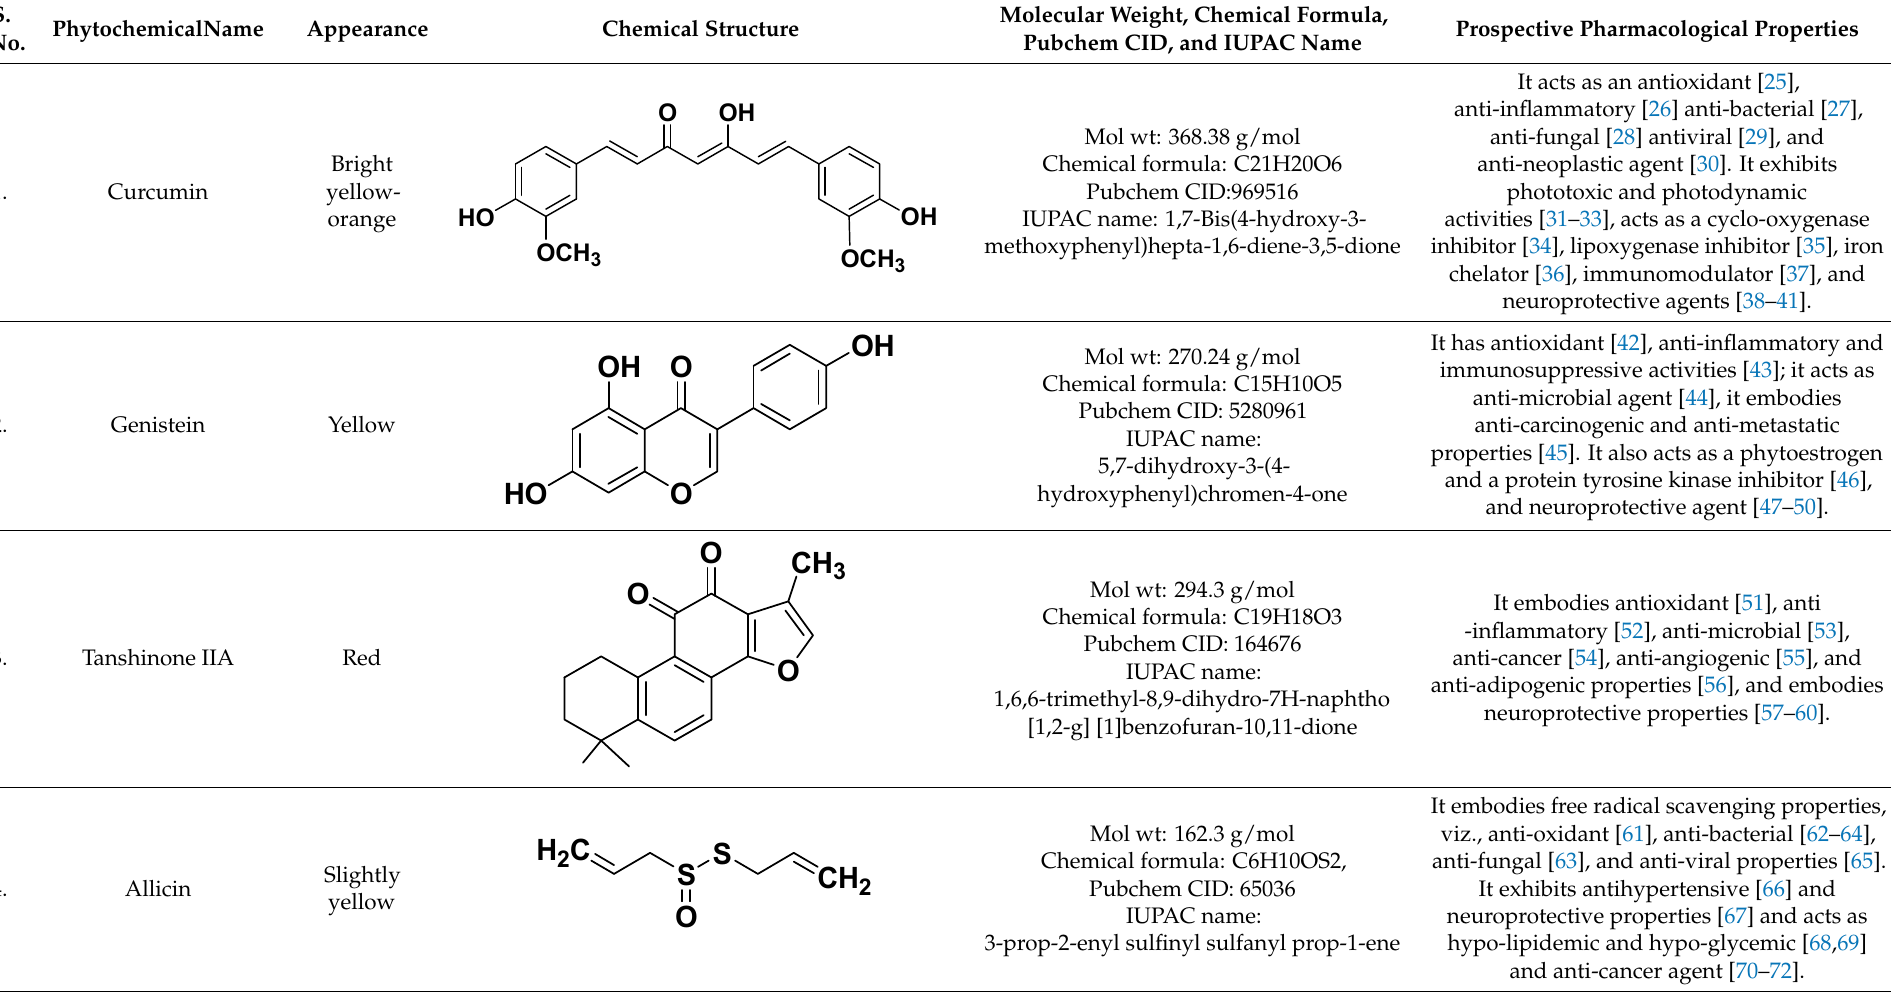
Table 1. Representative table highlighting various phytochemicals along with their pharmacological properties and therapeutic importance.